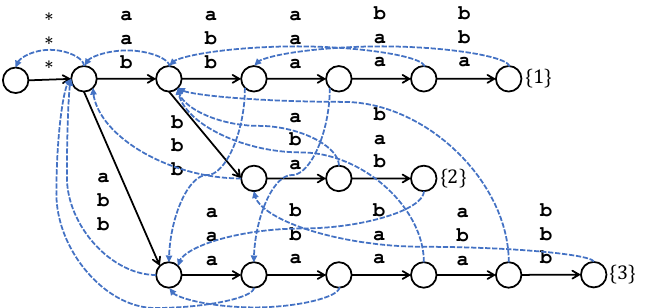
Figure 1. The multi-track AC-automaton MTAC ( D ) for D = { P 1 , P 2 , P 3 } , where P 1 = = ( abab , abba , bbab ) , and P = ( aabbab , bababb , baaaab ) . The asterisk ( aaabb , abaab , bbaaa ) , P 2 3 “*” is a special symbol that matches any symbol in Σ .